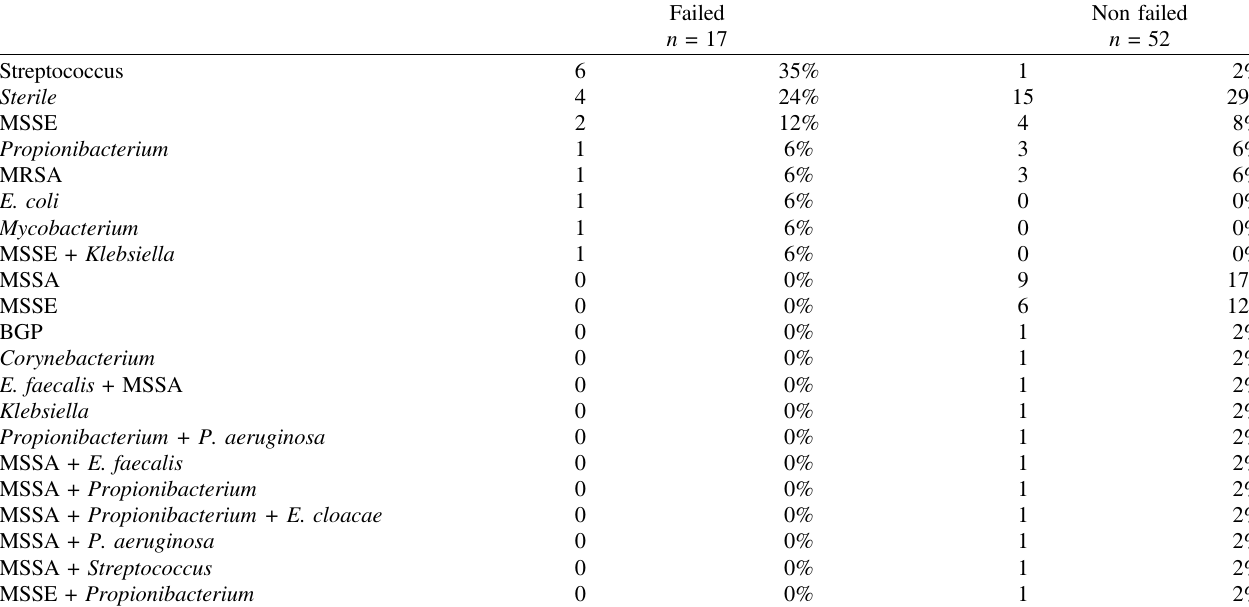
Table 2. Principal pathogens found in the infected joint after